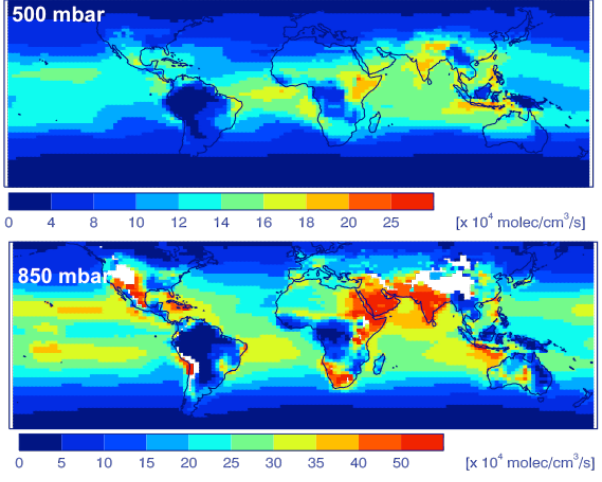
Figure 18. Mean methane loss rate (1988–2007; × 10 4 moleculescm − 3 s − 1 ) at 500mb (top) and 850mb (bot- tom) for the Base